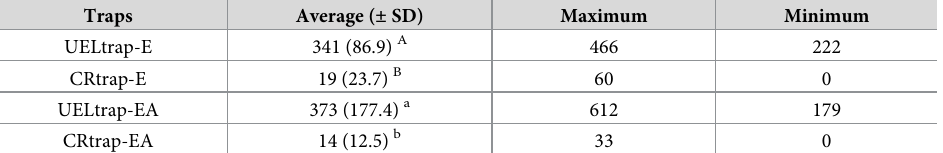
Table 1. Average, maximum and minimum Aedes eggs in the different traps from March to April 2017 in Lon- drina, Parana´, Brazil. Traps Average ( ± SD) Maximum Minimum UELtrap-E 341 (86.9) A 466 222 CRtrap-E 19 (23.7) B 60 0 UELtrap-EA 373 (177.4) a 612 179 CRtrap-EA 14 (12.5) b 33 0 SD = standard deviation. Different letters in the same column indicate a statistically significant difference (p < 0.05) between the average number of eggs obtained for the trap that collects the same stage (eggs or eggs/adults) using Student’s t-test or the Mann-Whitney